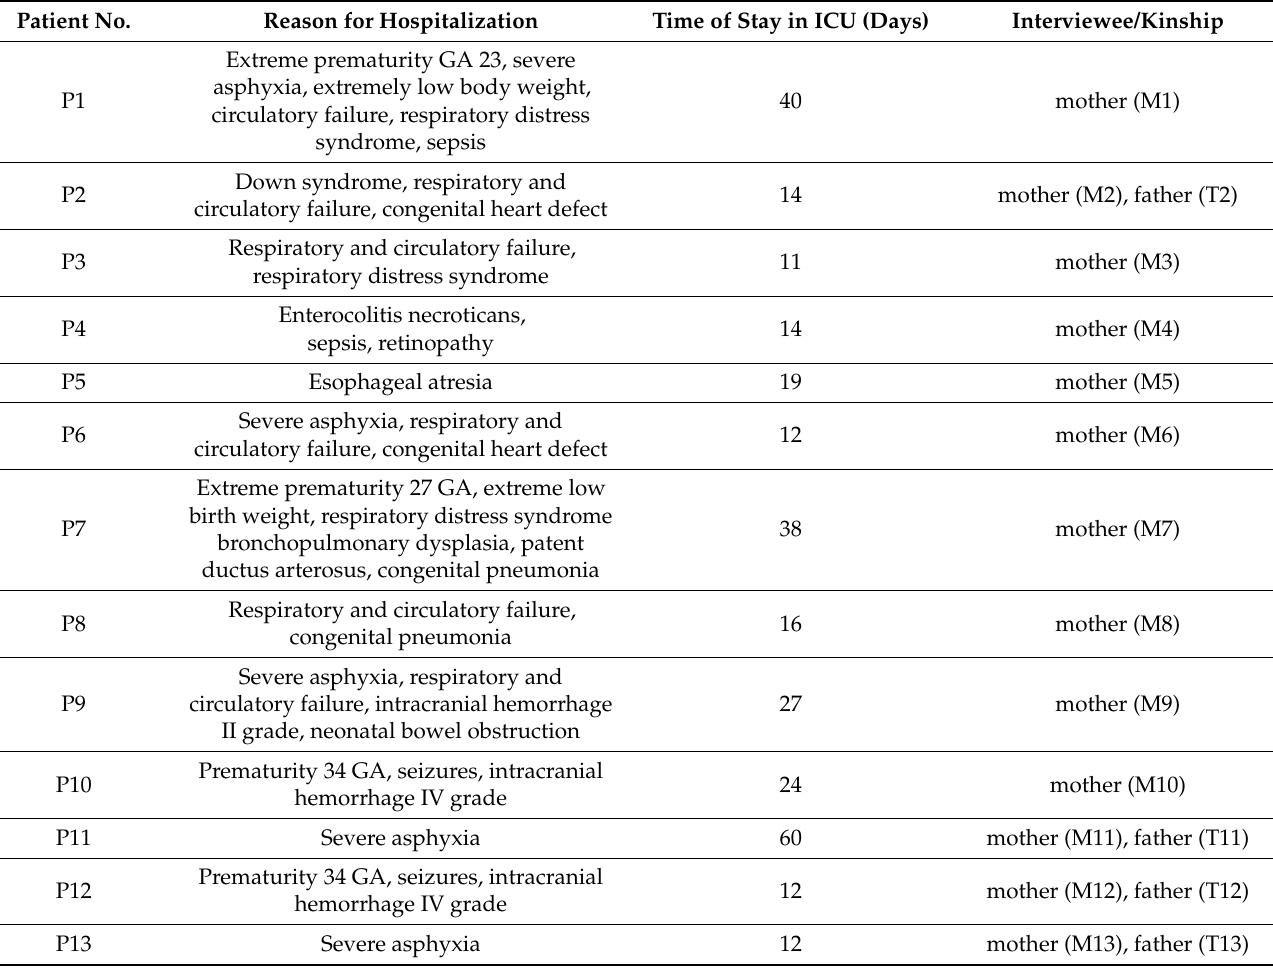
Table 1. Characteristics of the study